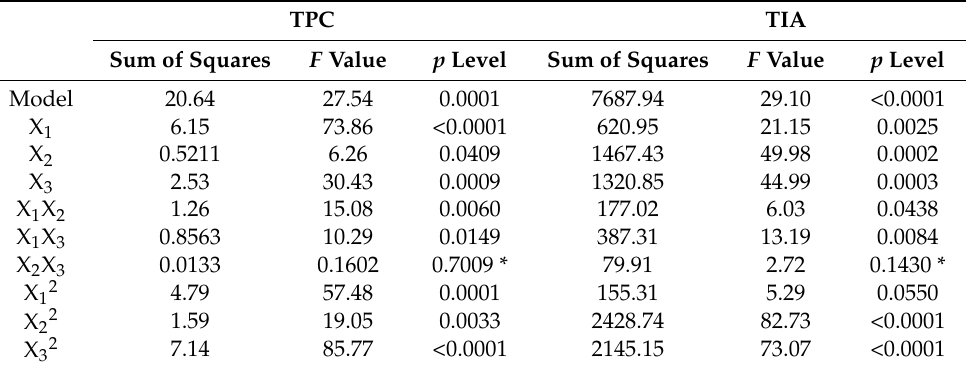
Table 3. Analysis of variance (ANOVA) of the TPC and TIA.